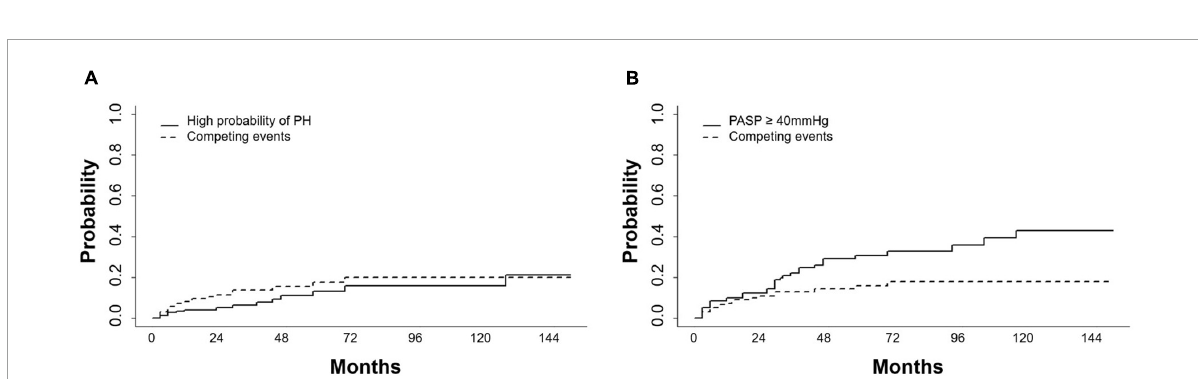
FIGURE2 Cumulative incidences of high probability of PH and PASP ≥ 40mmHg. (A) Cumulative incidences of high probability of pulmonary hypertension (PH) and (B) pulmonary artery systolic pressure (PASP) ≥ 40mmHg increased during dasatinib-therapy. Competing events included switching to another TKI, chemotherapy, a transplant or death.